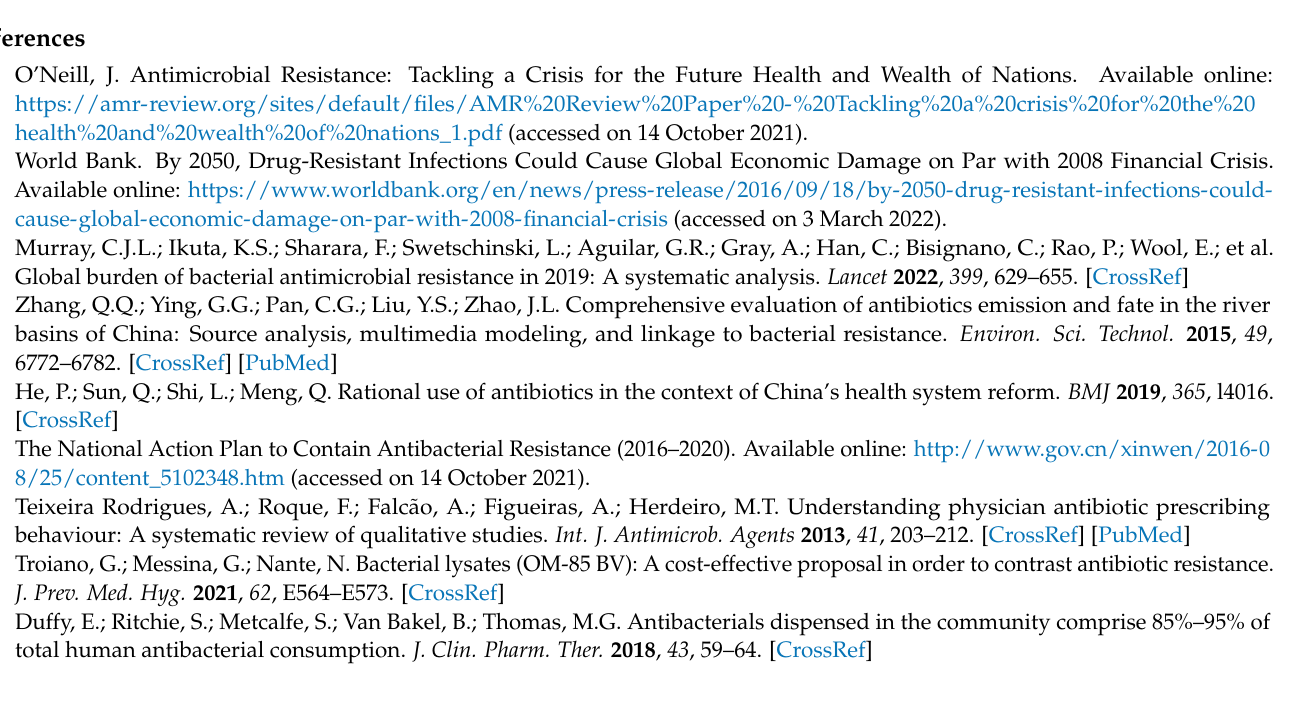
prescription rates; Figure S3: Effect of the educational intervention on the antibiotic injection rates; Figure S4: Effect of the educational intervention on the multiple antibiotic rates; Figure S5: Effect of the educational intervention on the inappropriateness of antibiotic